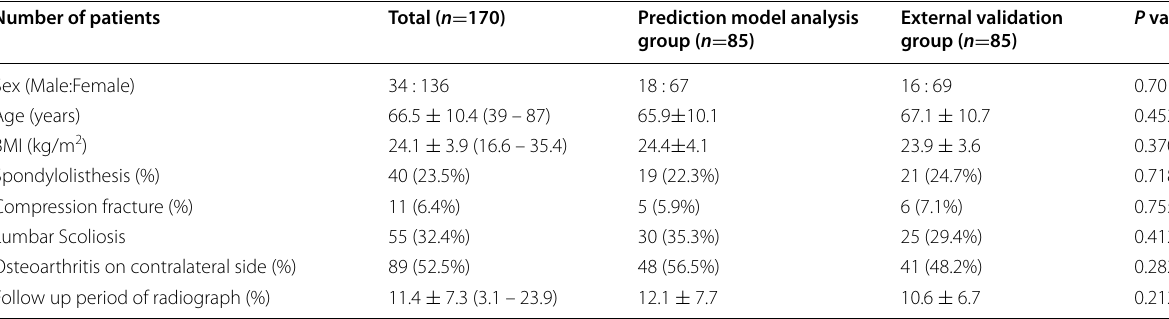
Table 1 Patients’ characteristics